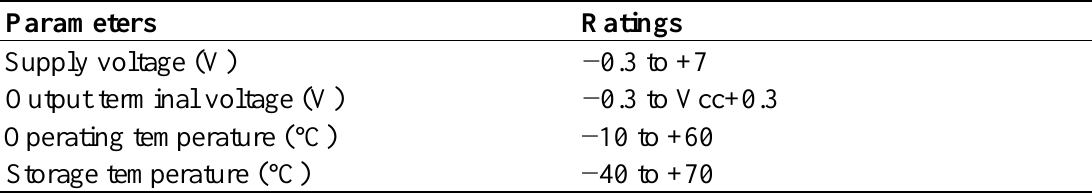
Table 2. Absolute maximum